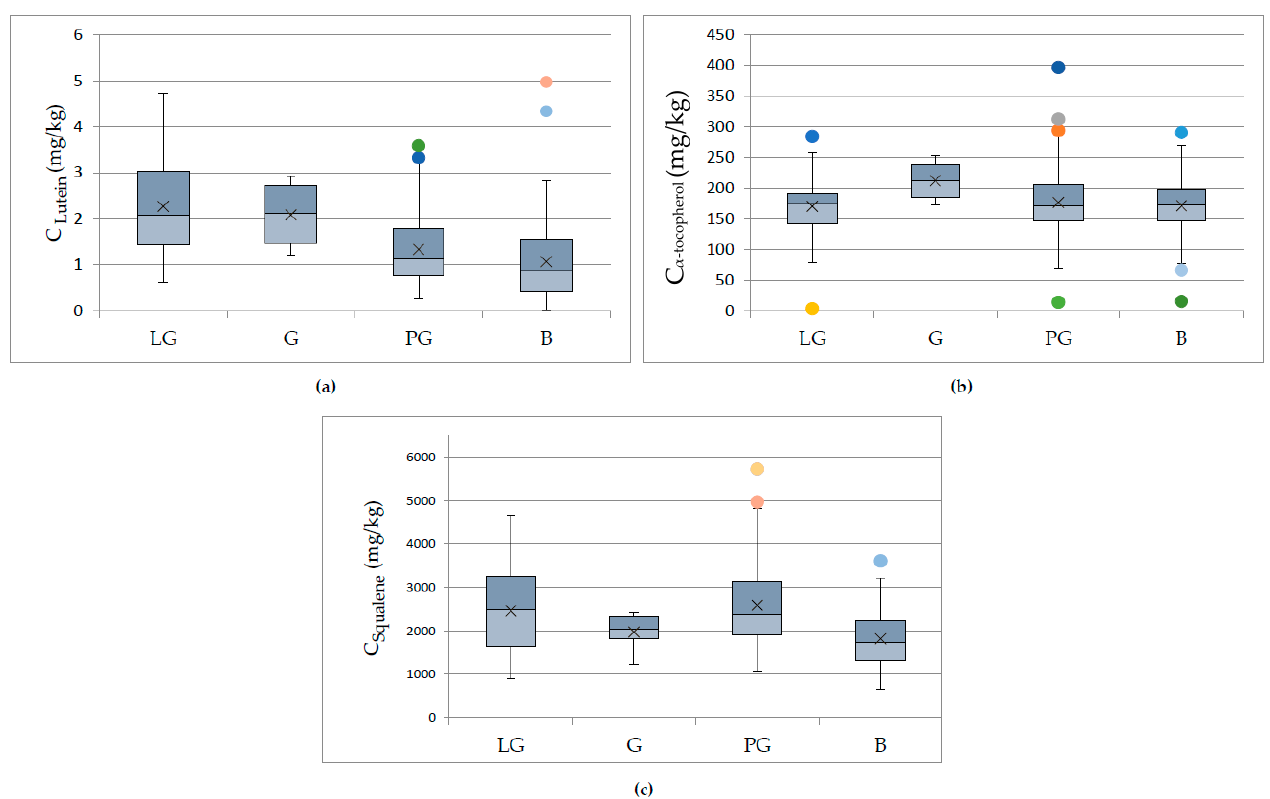
Figure 5. Box and whisker plots presenting the concentration of ( a ) lutein, ( b ) α -tocopherol, and ( c ) squalene in olive oils from Lesvos island regarding the maturity level of the fruit. Green (G, n = 4 samples), Light Green (LG, n = 24 samples), Purple-Green (PG, n = 67 samples), Black (B, n = 88 samples).